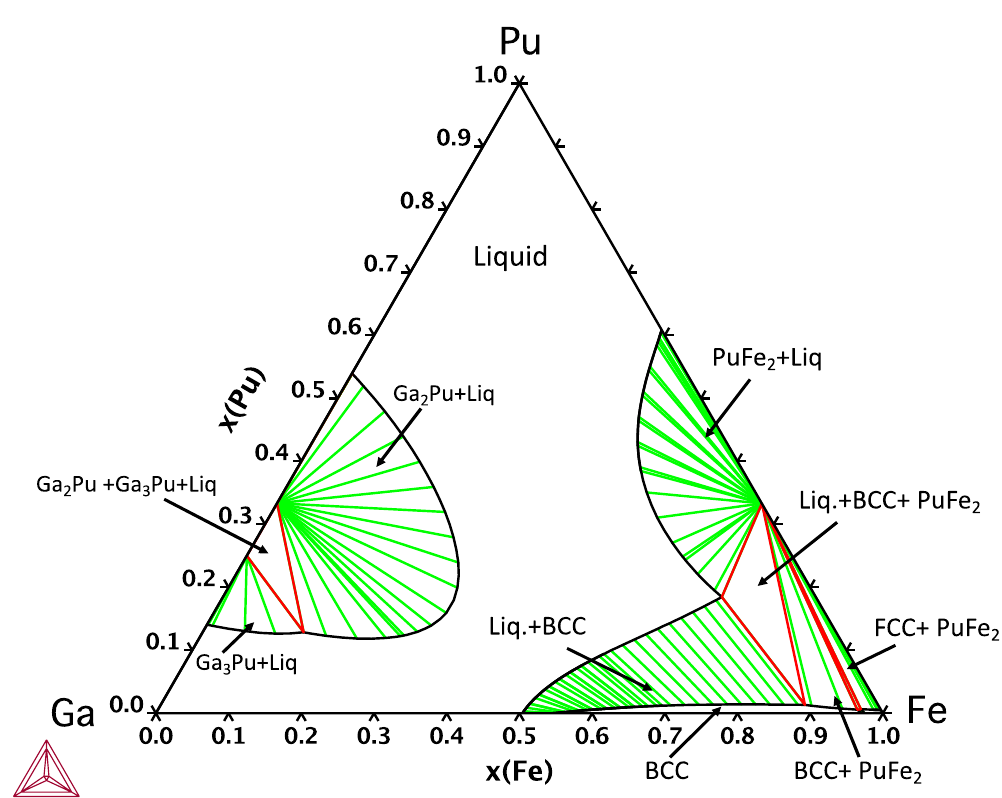
Figure 7. Pu-Fe-Ga ternary section at 1000 °C based on the present CALPHAD assessment.